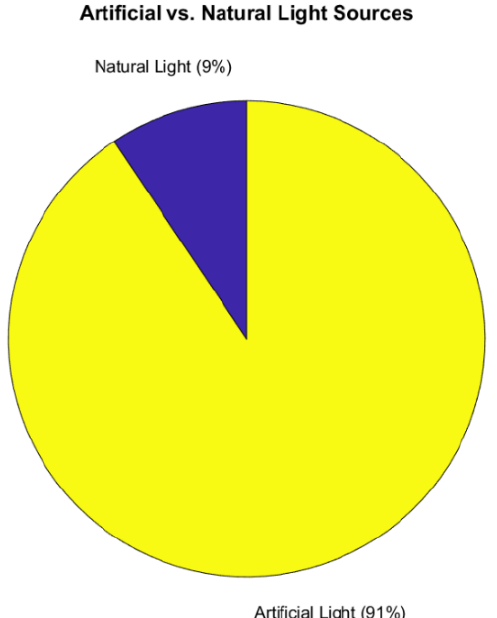
Figure 15. Comparison between the number of references using natural light vs. artificial.